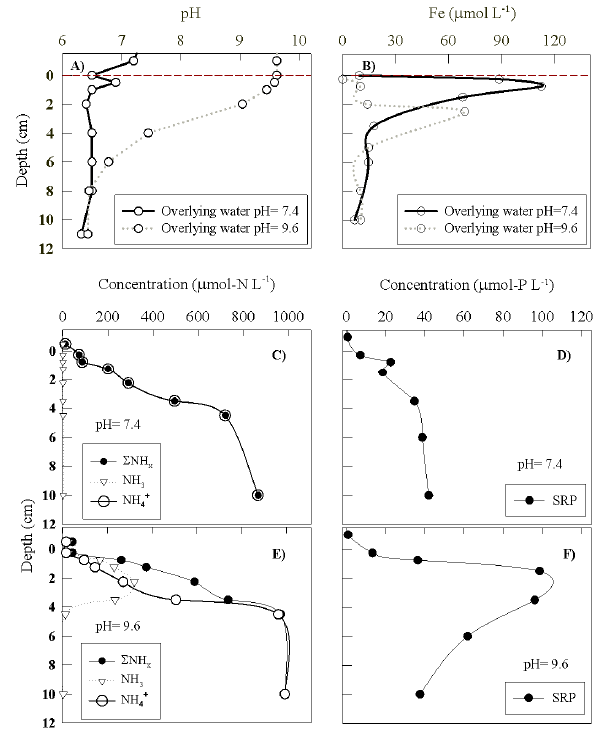
Figure 1. Powerline porewater profiles in the upper 10 cm of sediment under high pH (9.6) and normal pH (7.4) treatments, including vertical changes of pH (A), porewater Fe (B), SRP (D,F), and ∑ NHx (C,E). The dashed line is the interface of sediment-water. Changes in ammonium speciation, resulted from surface pH elevation, were calculated by the equilibrium of NH 3 and NH 4+ .